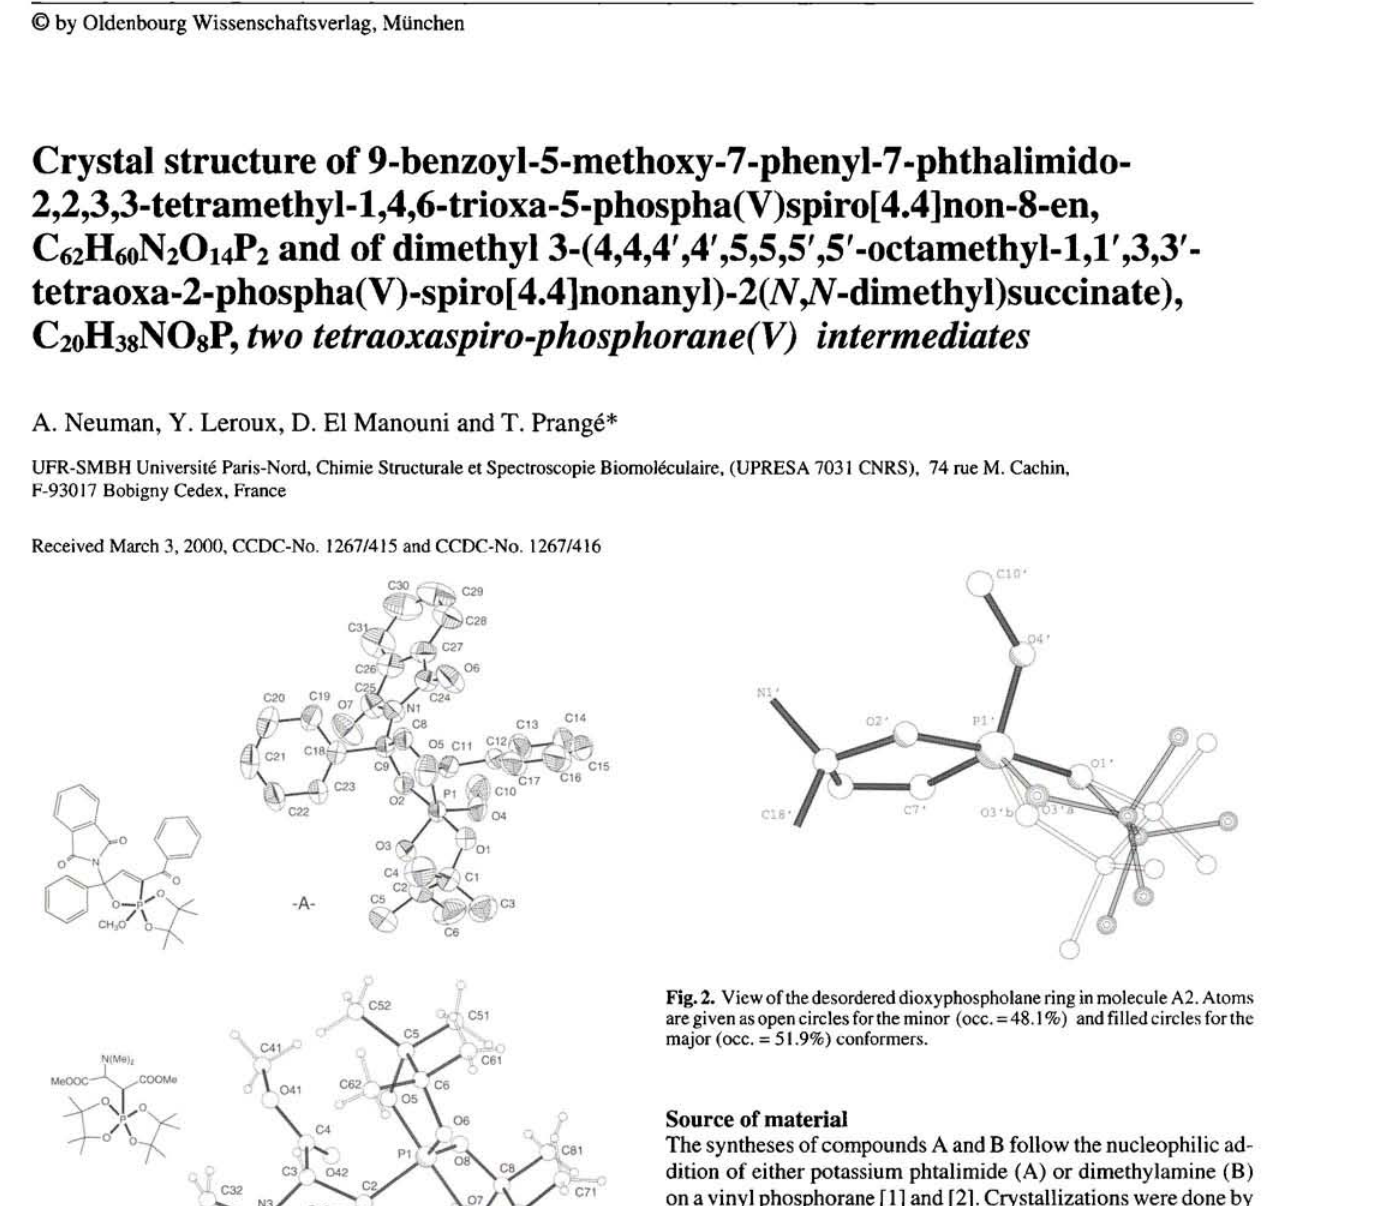
Fig. 1. Left: Formulae of A and B. Right: Perspective viewes of A (one mole- cule of the a.u.) with ellipsoids at the 50% probability level and B (PLUTO drawing) with hydrogen atoms as small open